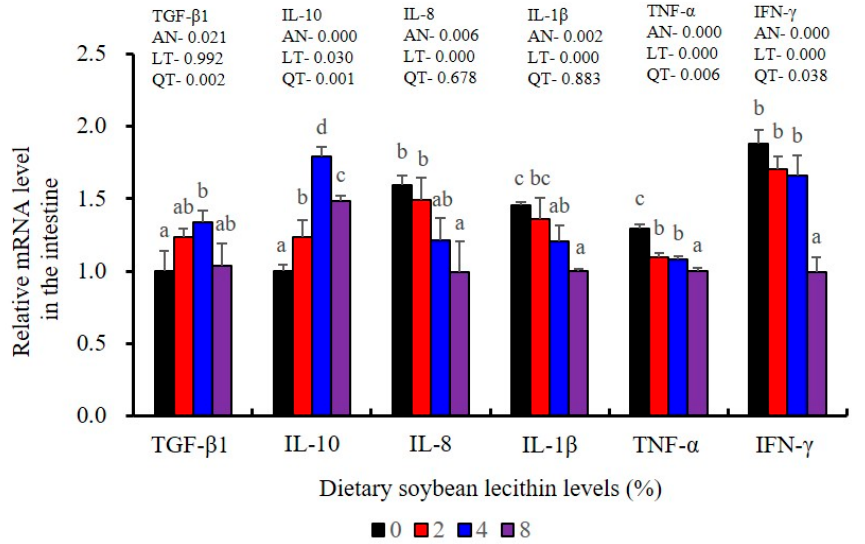
Figure 9. Effect of dietary soybean lecithin on relative gene expression levels of anti-inflammatory and pro-inflammatory cytokines in the intestine of juvenile largemouth bass. Bars with different letters indicate significant differences ( p < 0.05), while that with the same letter or no letter superscripts indicate no significant differences ( p > 0.05), AN: ANOVA, LT: linear trend, QT: quadratic trend.